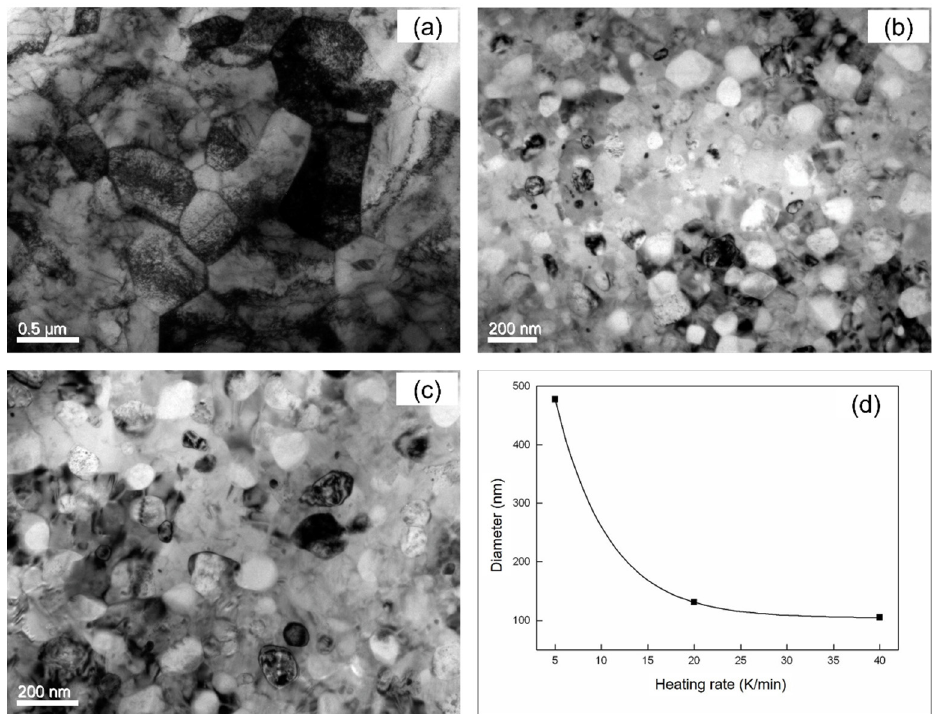
Figure 7. Bright field micrograph of TEM of the crystallized Fe 85 B 15 alloy annealed at the heating rates of 5 K min − 1 ( a ), 20 K min − 1 ( b ) and 40 K min − 1 ( c ). ( d ) The average crystal size after crystallization at the heating rates of 5, 20 and 40 K min − 1 has been calculated with linear intercept method accordingly (symbols). The line is drawn as a guide to the eye.